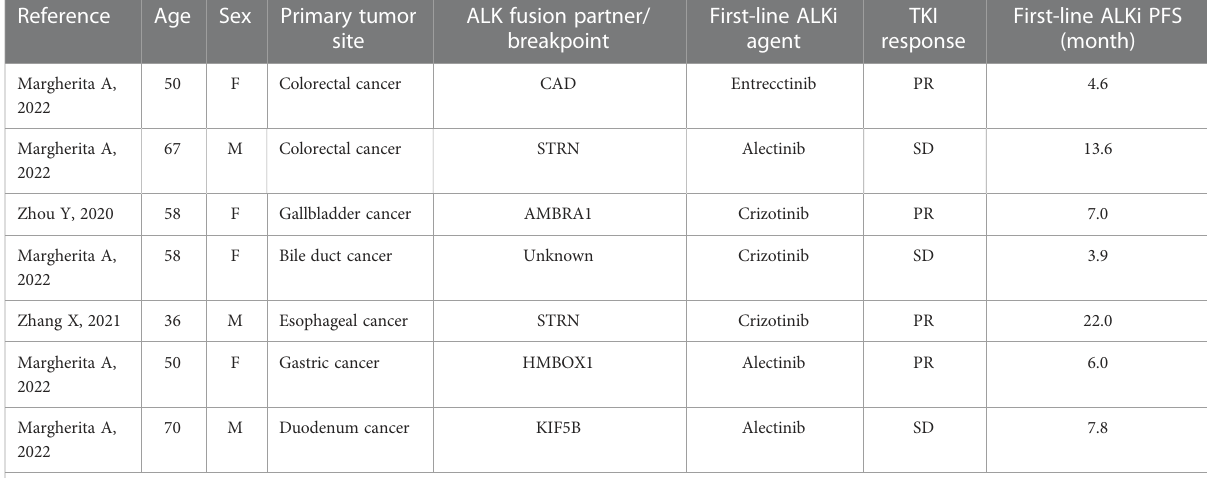
showing a signi fi cant improvement of progression-free survival compared to crizotinib